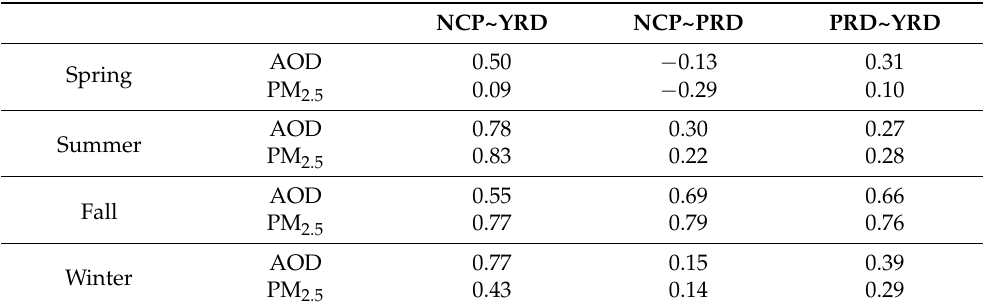
Table 4. Correlation coefficients of seasonal mean AOD and surface PM 2.5 between 2006 and 2017 among NCP, YRD, and